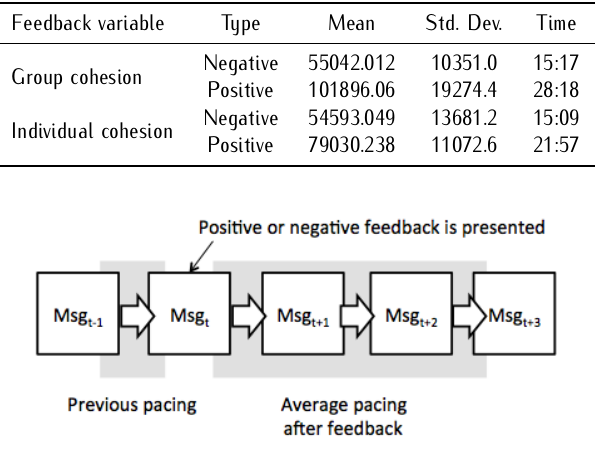
Figure 9. Comparison of previous pacing to future average pacing.